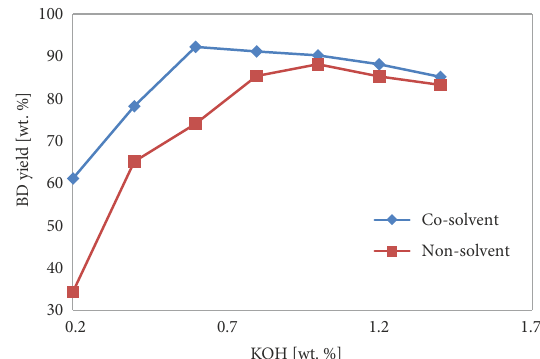
Figure 1. Influence of KOH concentration on BAO conversion